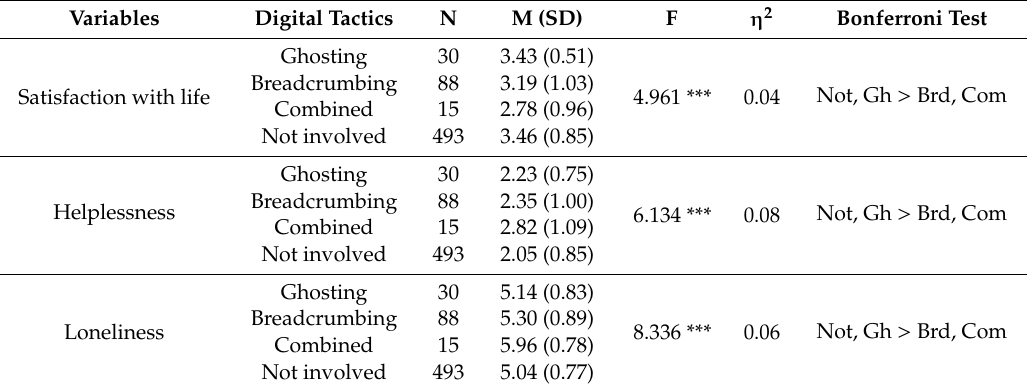
Table 2. Di ff erences in the psychological constructs among victims of ghosting, breadcrumbing, combined victims, and those not